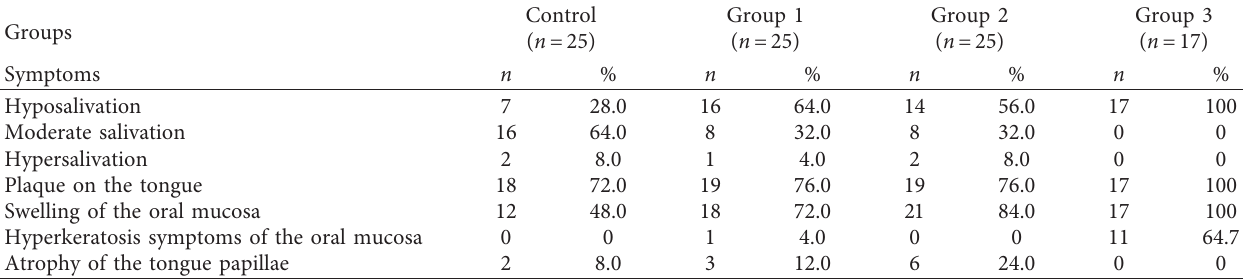
Table 1: The oral examination results among patients with GERD.